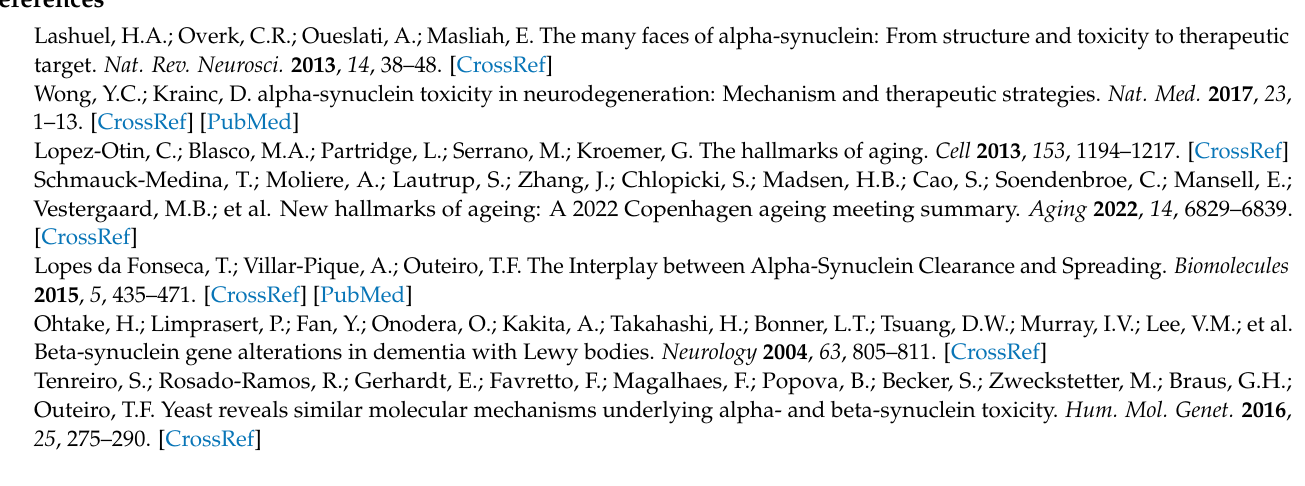
indicated ages. Figure S2: Immunofluorescence of the two aSynuclein (aSyn) antibodies used in this study. Figure S3: RNA expression levels of Snca , Sncb and Sncg in mice retinas at the indicated